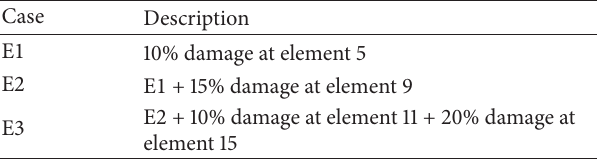
Table 2: Various damage